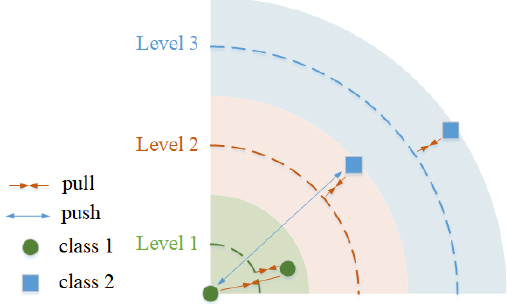
Figure 5. Multi-level similarity regularization for SCL model.